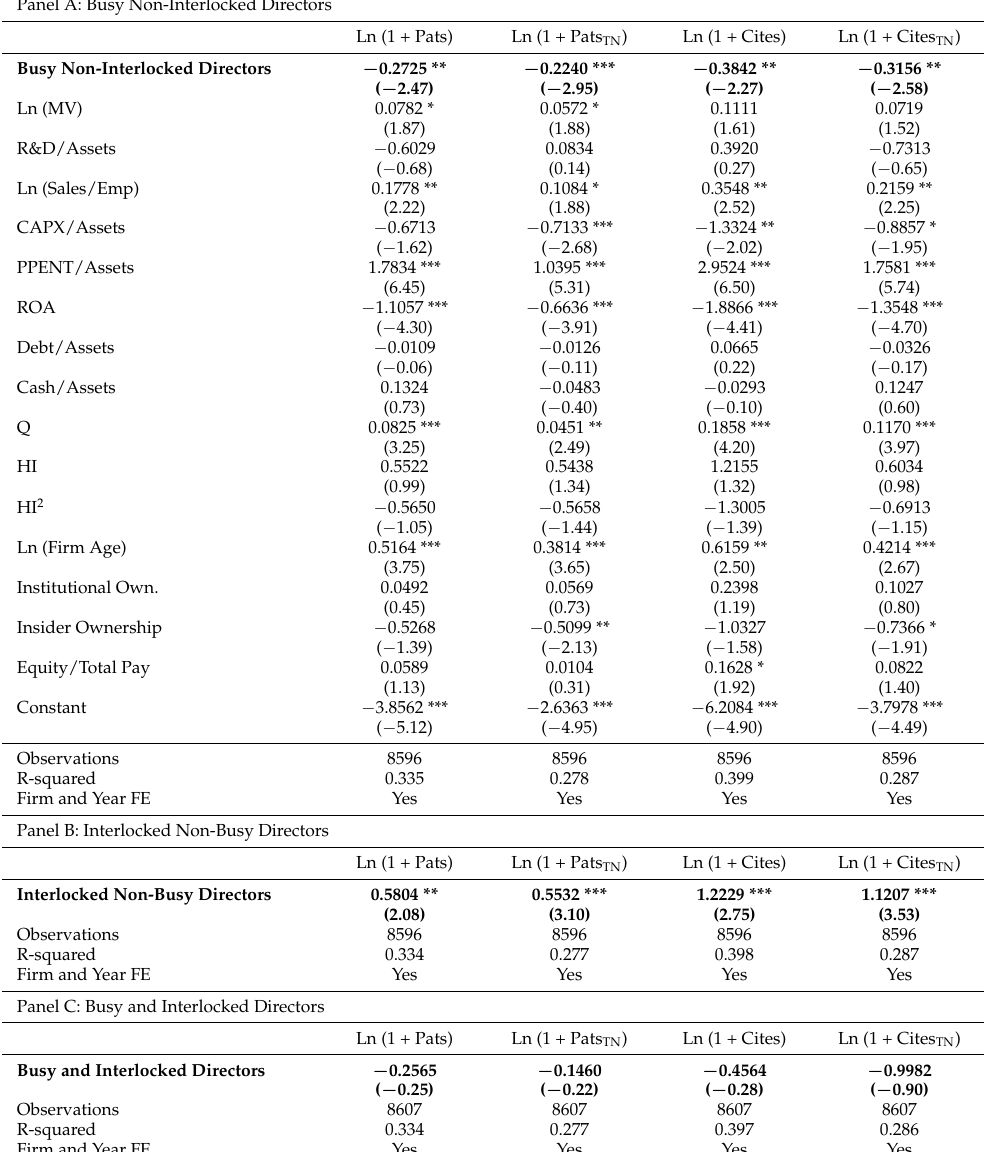
Table 5. Regressions of Innovation on the Interaction of Director Busyness and Interlocks. This table presents regression results of Innovation on interactions between Director Busyness and In- terlocked Directors. Panel A examines Busy Non-Interlocked Directors, defined as the percentage of directors who are busy (on three or more other boards) but not interlocked; Panel B examines Interlocked Non-Busy Directors, defined as the percentage of directors who are not busy but inter- locked; Panel C examines Busy and Interlocked Directors, defined as the percentage of directors who are both busy and interlocked. Control variables are omitted for brevity in Panels B and C. All regressions contain firm and year fixed effects. All except binary variables are winsorized at the upper and lower 1% levels. Full variable definitions are provided in the Appendix A. T-statistics are reported in parentheses. Standard errors are adjusted based on the Huber-White sandwich estimate of variances and are clustered by firm. *** indicates significance at the 1% level, ** 5% and *